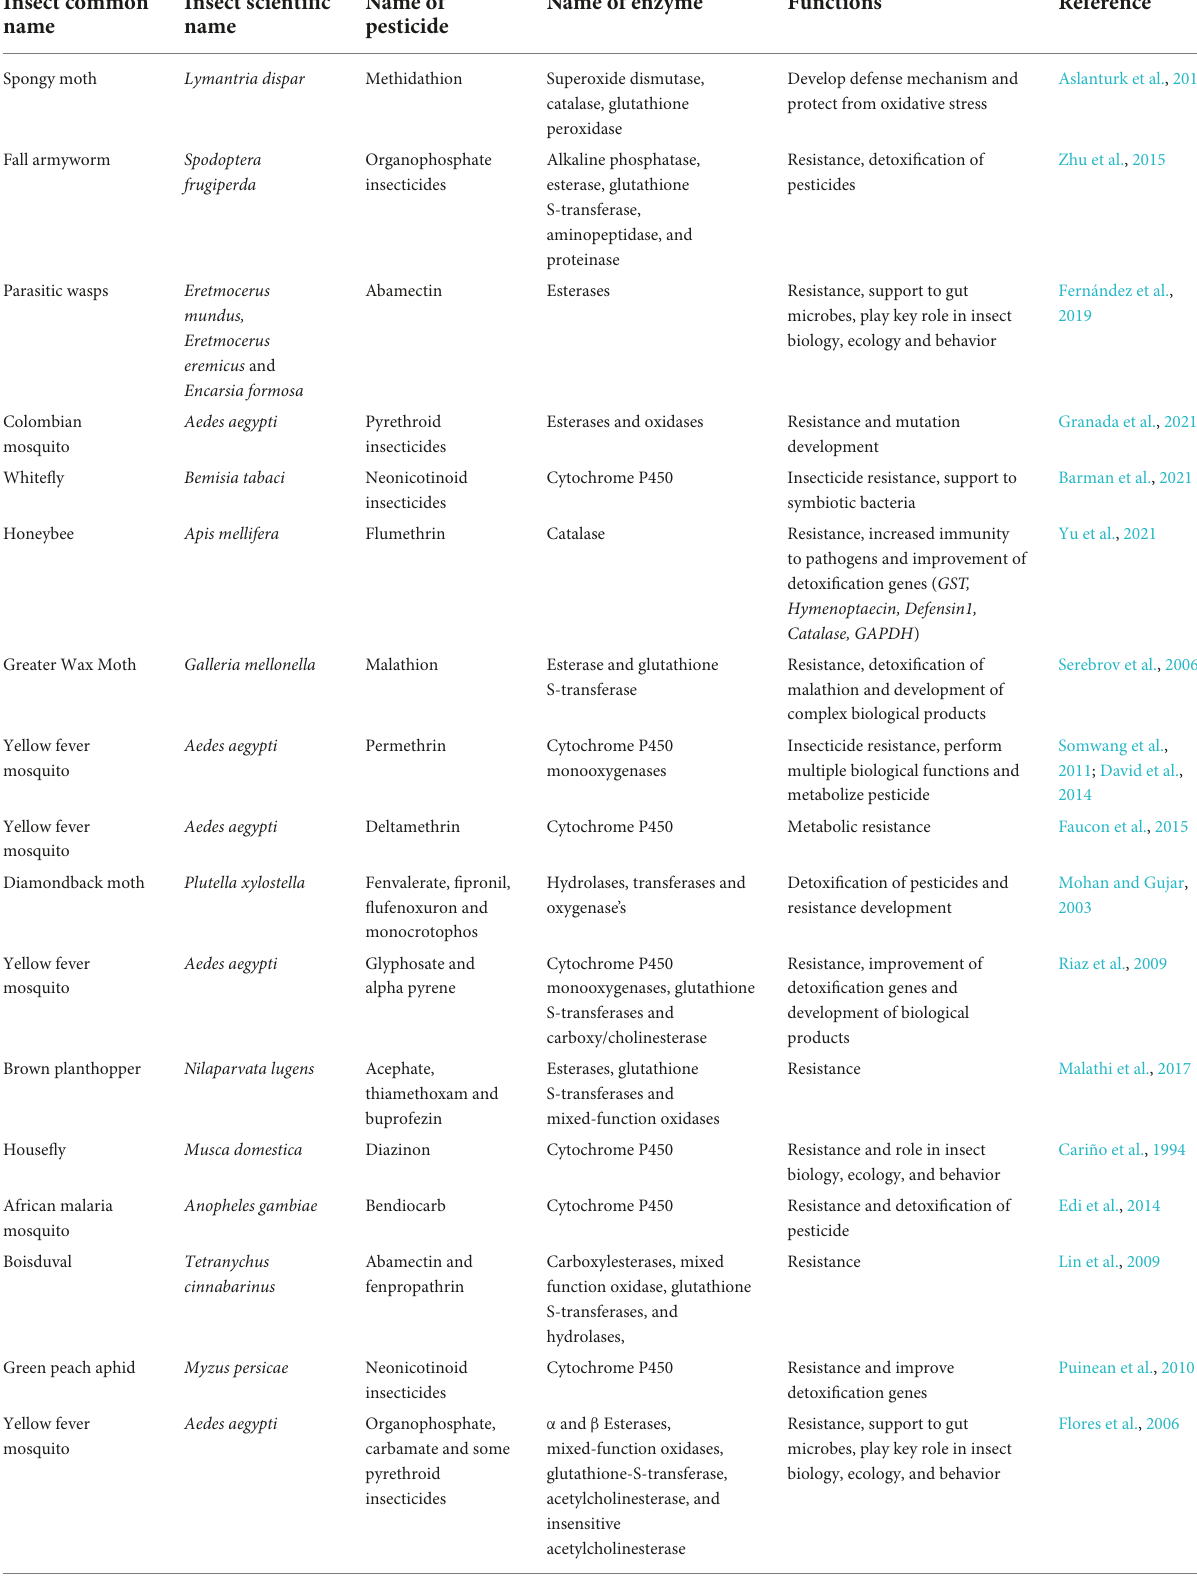
TABLE 2 Functions of insect enzymes in detoxification of pesticides and insect